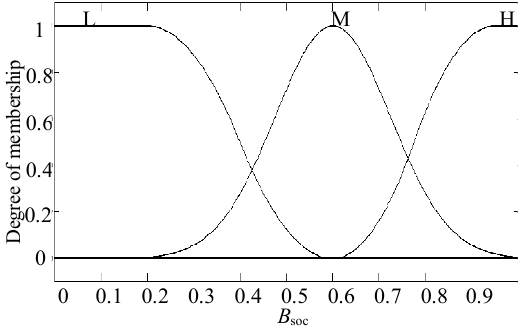
Figure 7. Membership function of B SOC .